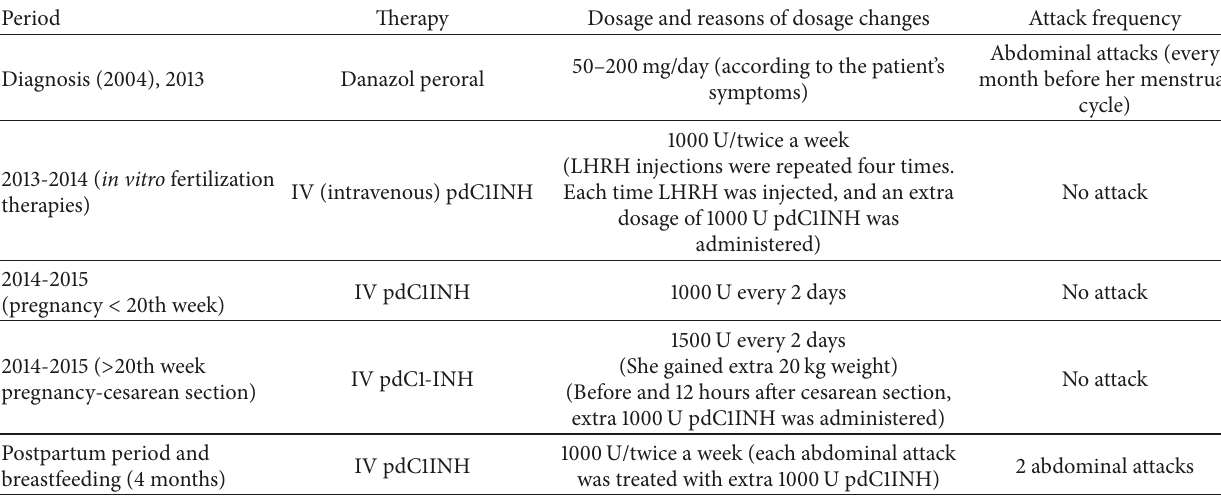
Table 1: The schema of